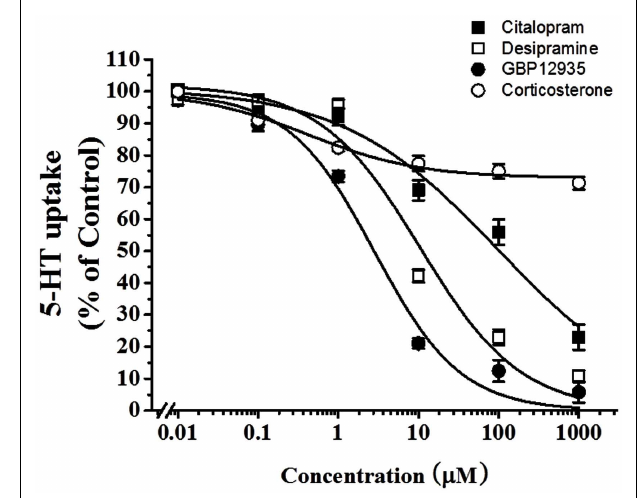
FIGURE 2 | Kinetic analyses of 5-HT uptake in HBVSMCs. Concentration dependence of 5-HT (0.1 µ M to 50mM) uptake was determined by measuring [ 3 H]5-HT uptake at room temperature for 30min.Values are means ± SEM of three experiments carried out in triplicate.